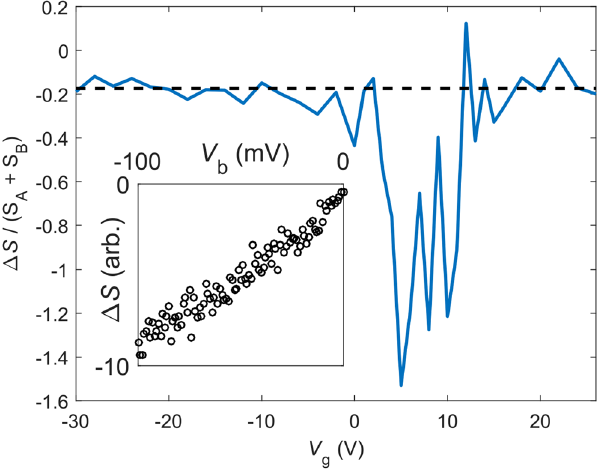
Figure 5. HBT exchange correction ∆ S vs. V obtained from low-bias cross correlation experiments g → . The solid line indicates our HCL model result S S S /( ) 0 175 ∆ + = − . using extrapolated to V 0 b A B = . G G / 3 4 = − p 0 30 g